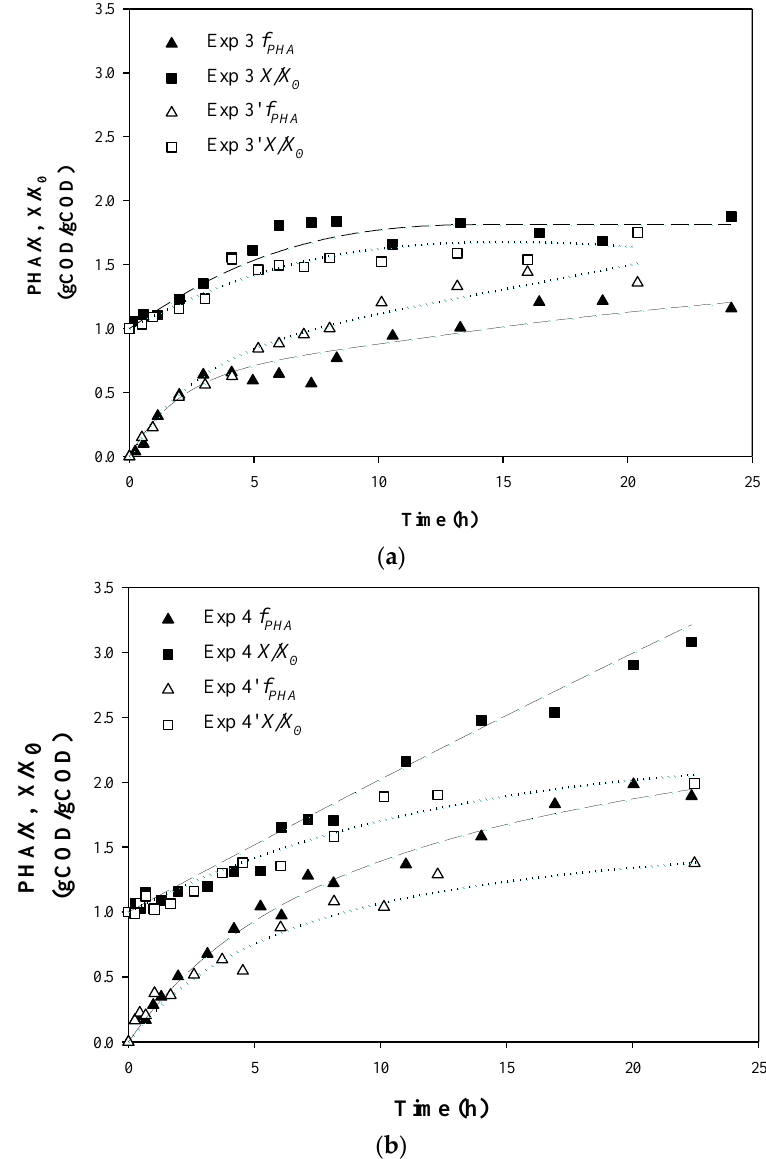
Figure 2. Experimental data for PHA fraction and relative active biomass production: ( a ) Experiment set 3: 50% acetic acid and 50% propionic acid fed simultaneously; and ( b ) Experiment set 4: 100% acetic acid alternating with 100% propionic acid. ▲ , ∆, PHA fraction respect to active biomass concentration f PHA ( PHA / X ); ■ , □, Active biomass concentration respect to the initial biomass concentration ( X / X 0 ). Dotted lines represent fitted data. Coefficients are given on gCOD basis.